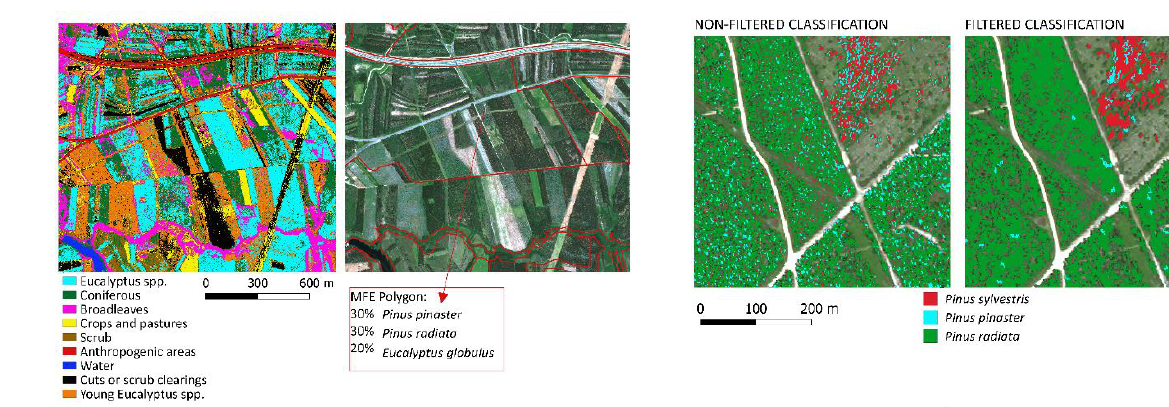
Figure 8. Results obtained for the pine species classification. Figure 7. Detail of the results obtained in the general filtered classification and the non-filtered one. Comparison classification. Reference image: RGB Worldview-2 image between the non-filtered classification and the filtered one. (5,3,2). MFE reference polygons from the Spanish Forest Map, (MAPA, 2011) are also shown as well as an example of the information about one of them.